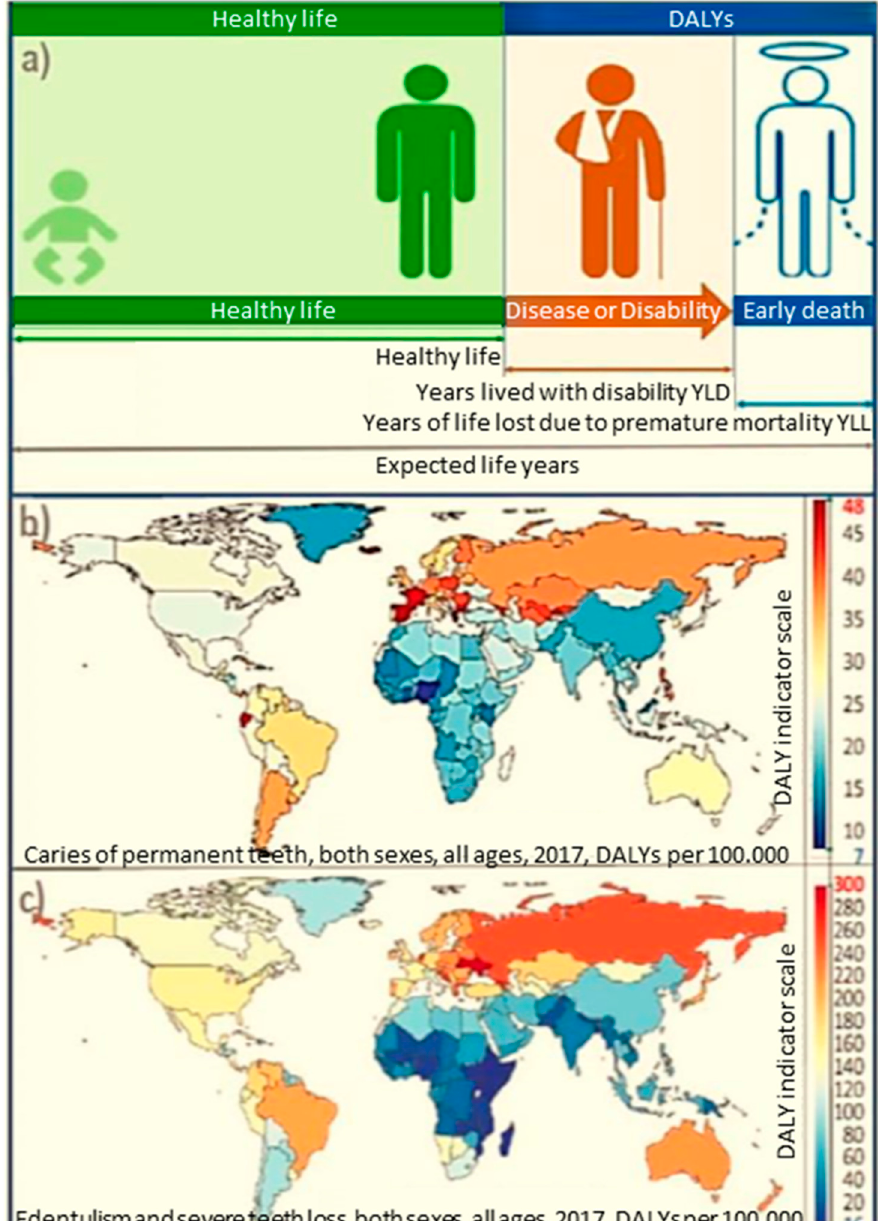
Figure 6. Disability-adjusted life years indicator (DALY); ( a ) an explanation of the DALY indicator; ( b , c ) geographical variation of the DALY indicator to 100,000 inhabitants: ( b ) due to the extent of caries, regardless of the sex and age of the patients; ( c ) due to the extent of edentulousness, regardless of the sex and age of the patients.